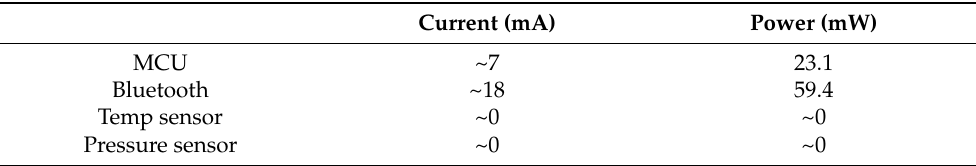
Figure 3. Power consumption of assembled devices with measurement scheme: ( a ) current versus on time and ( b ) power versus time with an applied bias (V DD ) of 3.3V. Table 1. Summary of current level and power consumption, corresponding to the microcontroller unit (MCU), Bluetooth module, temperature sensor, and pressure